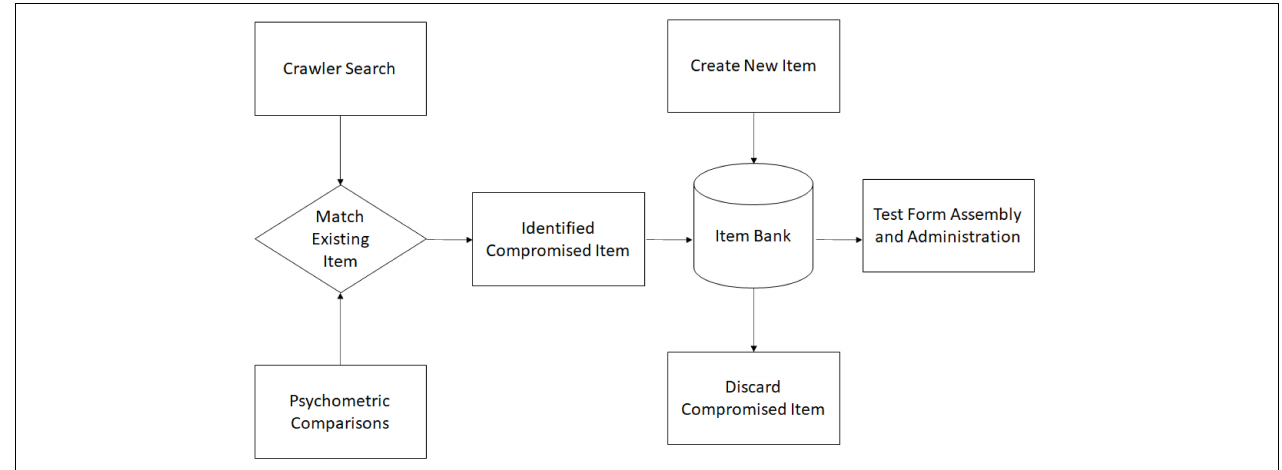
FIGURE 2 | Illustration of a simplified process for detecting compromised